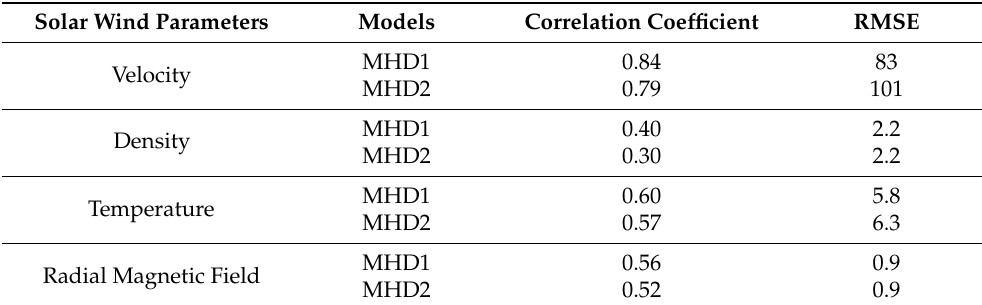
Table 2. Comparison of the solar wind modeling results with the Ulysses observations during CR2057 to